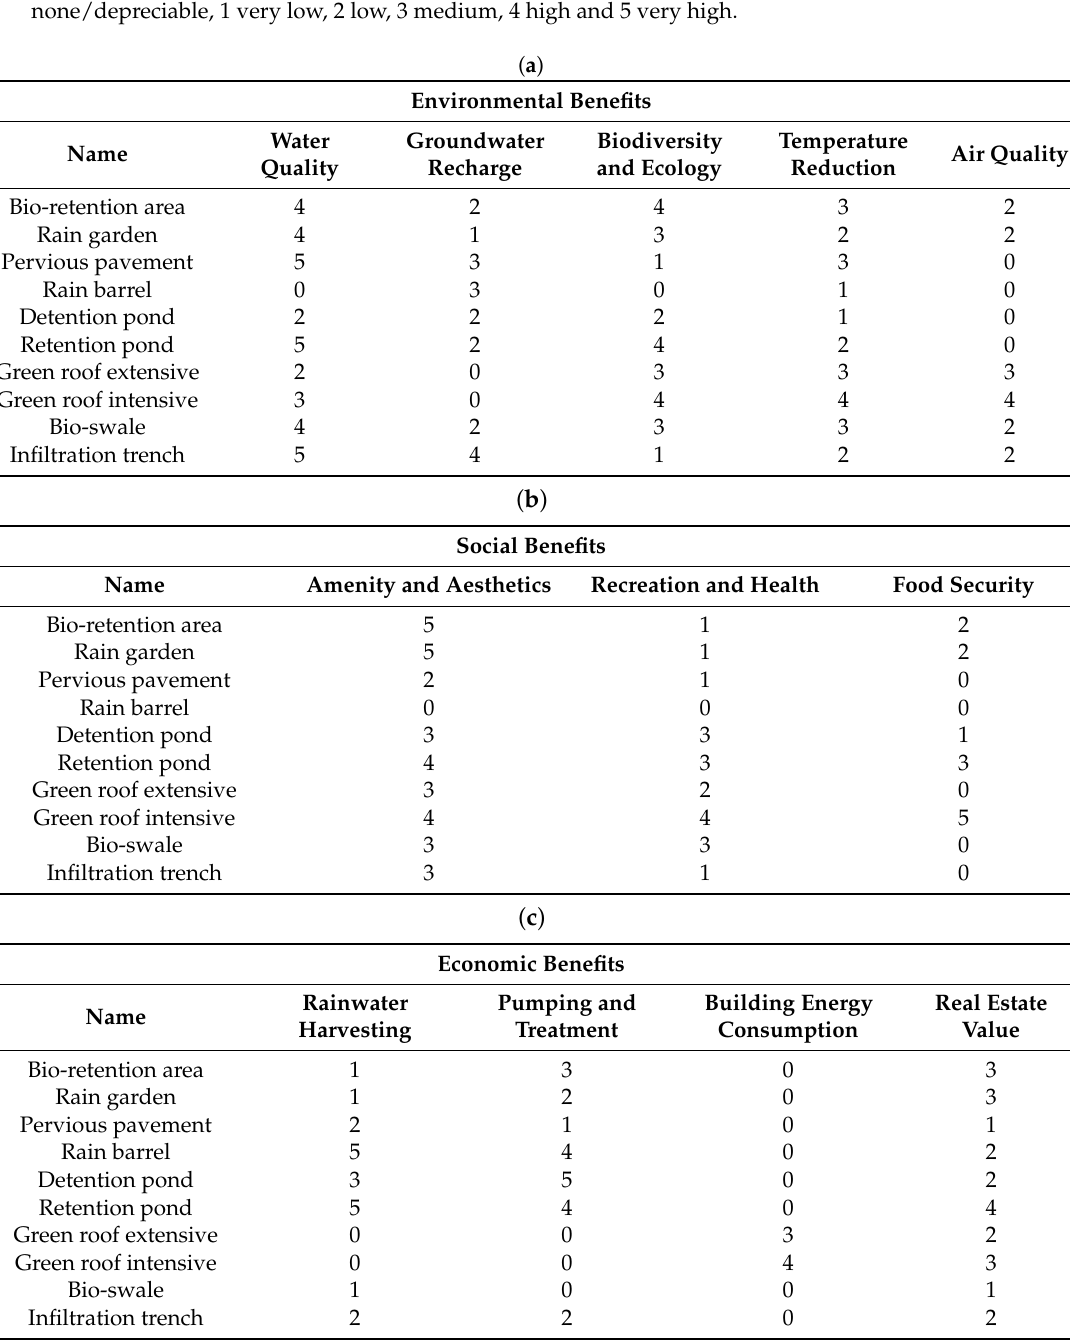
Table 2. ( a ) Impact of each measure on environmental benefits (data derived from [12,28,36,38,39]). The values of the indicators are: 0 none/depreciable, 1 very low, 2 low, 3 medium, 4 high, and 5 very high. ( b ) Impact of each measure on social benefits (data derived from [12,28,36,38]). The values of the indicators are: 0 none/depreciable, 1 very low, 2 low, 3 medium, 4 high, and 5 very high. ( c ) Impact of each measure on economic benefits (data derived from [12,36,38]). The values of the indicators are: 0 none/depreciable, 1 very low, 2 low, 3 medium, 4 high and 5 very